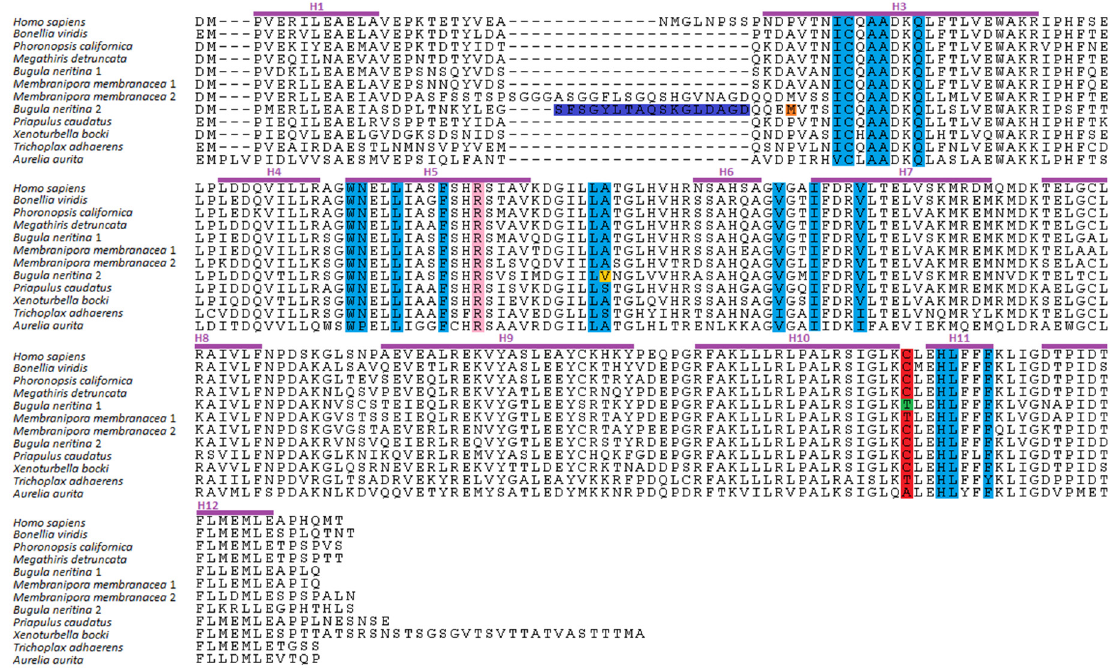
Figure 2. Alignment of RXR ligand-binding domains (LBD) from Homo sapiens , Bonellia viridis , Phoronopsis californica , Megathiris detruncata , Bugula neritina , Membranipora membranacea , Priapulus caudatus , Xenoturbella bocki , Trichoplax adhaerens , and Aurelia aurita . The α -helices from the human RXR α secondary structure are indicated with purple lines. The residues forming the pocket in human RXR α are highlighted in blue. The arginine residue that forms an ionic interaction with 9cisRA is highlighted in pink. The cysteine residue that forms a covalent bond with tributyltin (TBT) is highlighted in red. The B. neritina mutants RXR1 (Thr388Cys), RXR2 (Met231Ala), RXR2 (Val294Ala), and RXR2 ( ∆ Ser211-Asp227) are highlighted in green, orange, yellow, and dark blue, respectively.